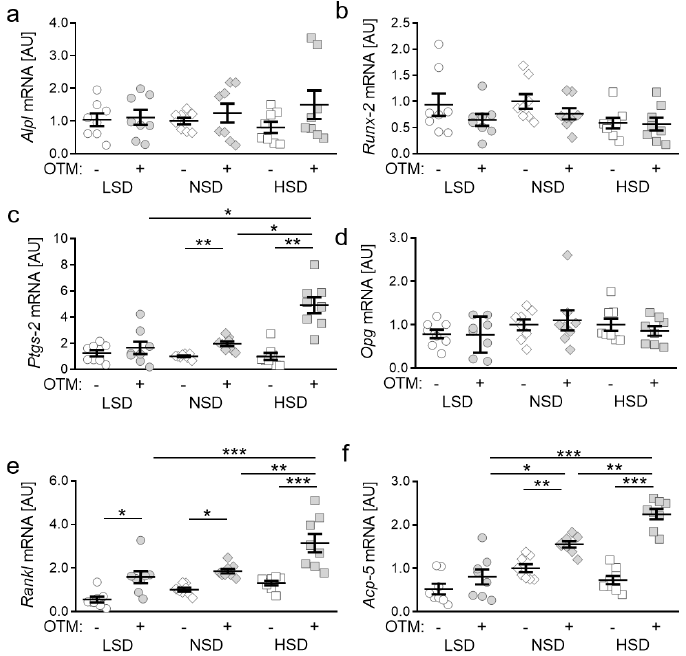
Figure 2. Gene expression of Alpl ( a ), Runx-2 ( b ), Ptgs-2 ( c ), Opg ( d ), Rankl ( e ) and Acp-5 ( f ) under low salt (LSD), normal salt (NSD) or high salt diet (HSD) in dental-periodontal tissue at the first upper molar, assessed with RT-qPCR ( n = 8). Symbols represent single data points, horizontal lines the arithmetic mean and vertical lines the standard error of the mean. AU: arbitrary units, OTM: orthodontic tooth movement, LSD: low salt diet, NSD: normal salt diet, HSD: high salt diet. Statis- tics : ANOVA followed by Holm–Sidak multiple comparison tests. * p < 0.05; ** p < 0.01; *** p < 0.001.